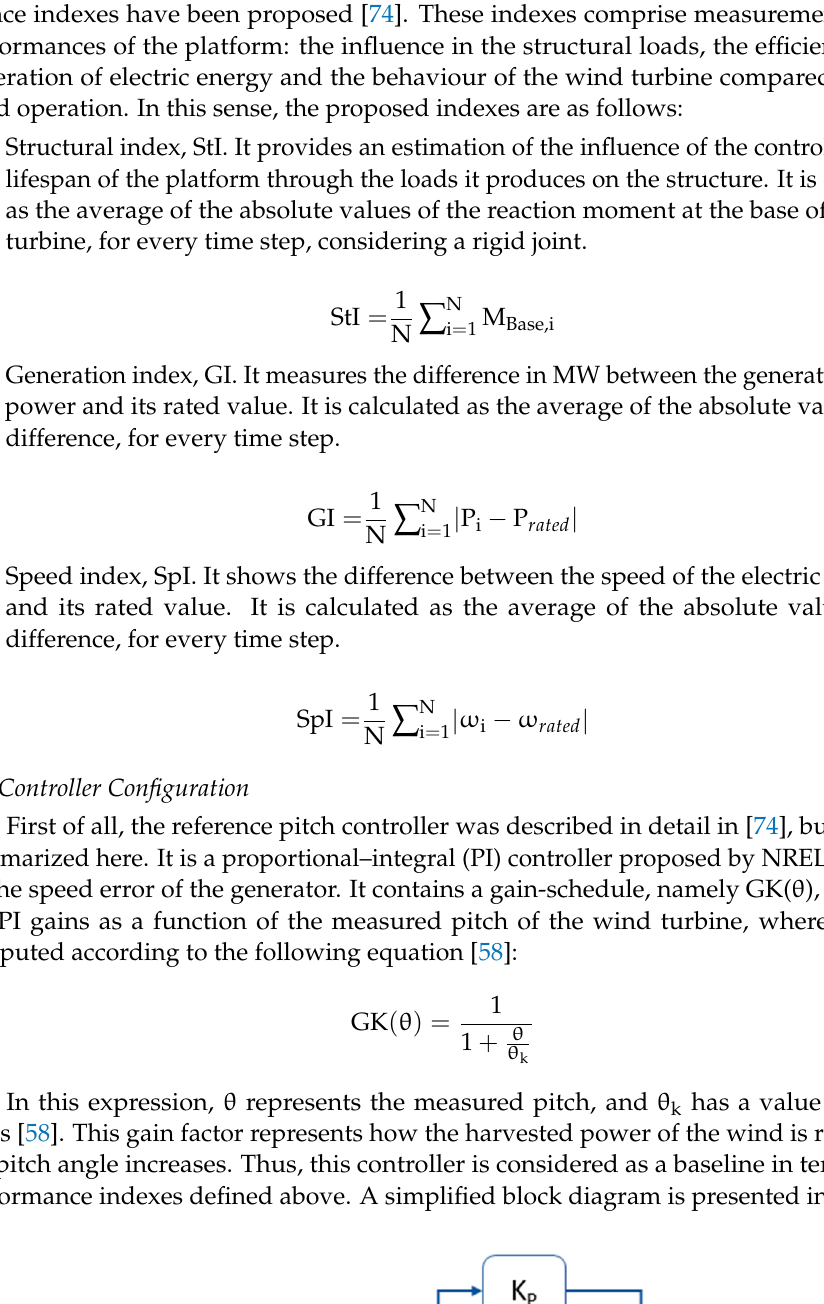
Figure 4. Simplified block diagram and implementation of the reference PI in Simulink. Secondly, as shown in the introductory section, fuzzy control is a promising option for improving the performance of wind turbines, particularly in the case of the ones placed on semi-submersible platforms. However, there can be different options to define the fuzzy controller configuration. One possibility, discussed in [74], is to design a fuzzy con- troller to substitute the conventional PI controller. In this case, the fuzzy controller re- ceives the generator speed as an input and produces a pitch reference for the wind turbine (see Figure 5). This fuzzy controller is known as Independent Fuzzy Logic Controller. Specifically, this fuzzy controller is of Mamdani-type. Membership functions are triangu- lar and trapezoidal for the input, and triangular for the output. A set of ten rules was defined and tuned according to the expert knowledge of EnerOcean. Based on the perfor- mance indexes, results showed a better performance compared with the reference control- ler. The performance indexes of this controller, re-calculated under the new simulation scenarios, are shown in Tables 2–4 in the column labelled as Independent Fuzzy Logic Controller, along with the values for the controllers proposed in this work. Figure 5. Simplified block diagram of the Independent Fuzzy Logic Controller. Thirdly, another possibility is to keep the conventional controller (PI) and to integrate a fuzzy controller acting as a supervisor, modifying the PI gains. This configuration is described in detail in [75]. The fuzzy controller is also of Mamdani-type. Membership functions are triangular and trapezoidal for both input and output. Seven rules were tuned based on the expert knowledge of EnerOcean. A simplified block diagram is shown in